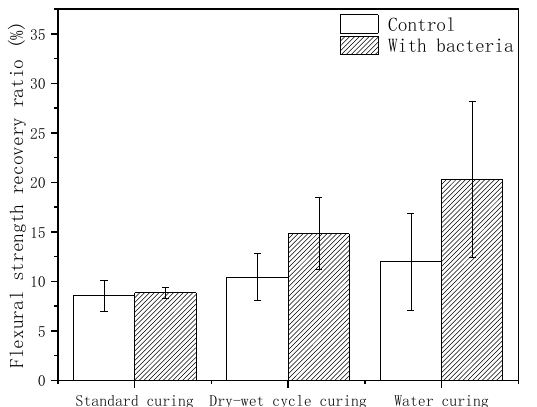
Figure 6. Flexural strength recovery ratio of mortar specimens under different exposure environments. Three specimens were tested for each exposure environment.